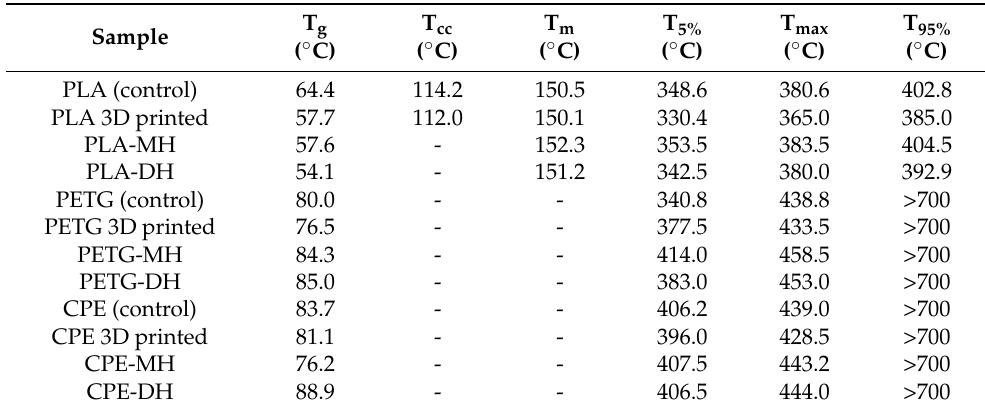
Table 2. DSC and TGA parameters of each printed